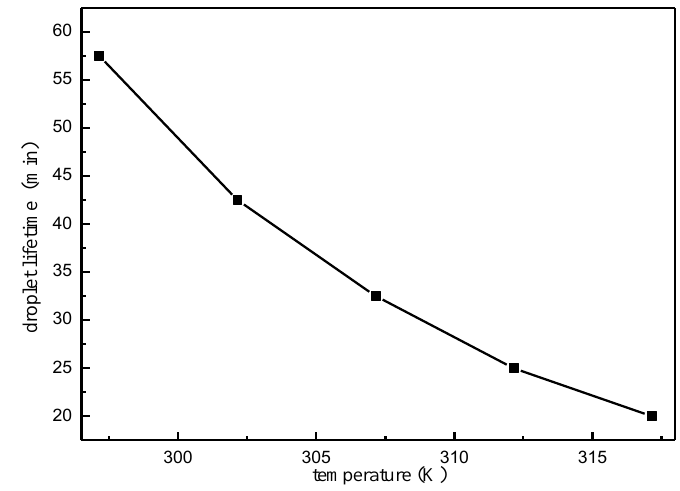
Figure 15. Droplet life versus ambient temperature variation curve. The variation of droplet evaporative mass with time at different ambient tempera-